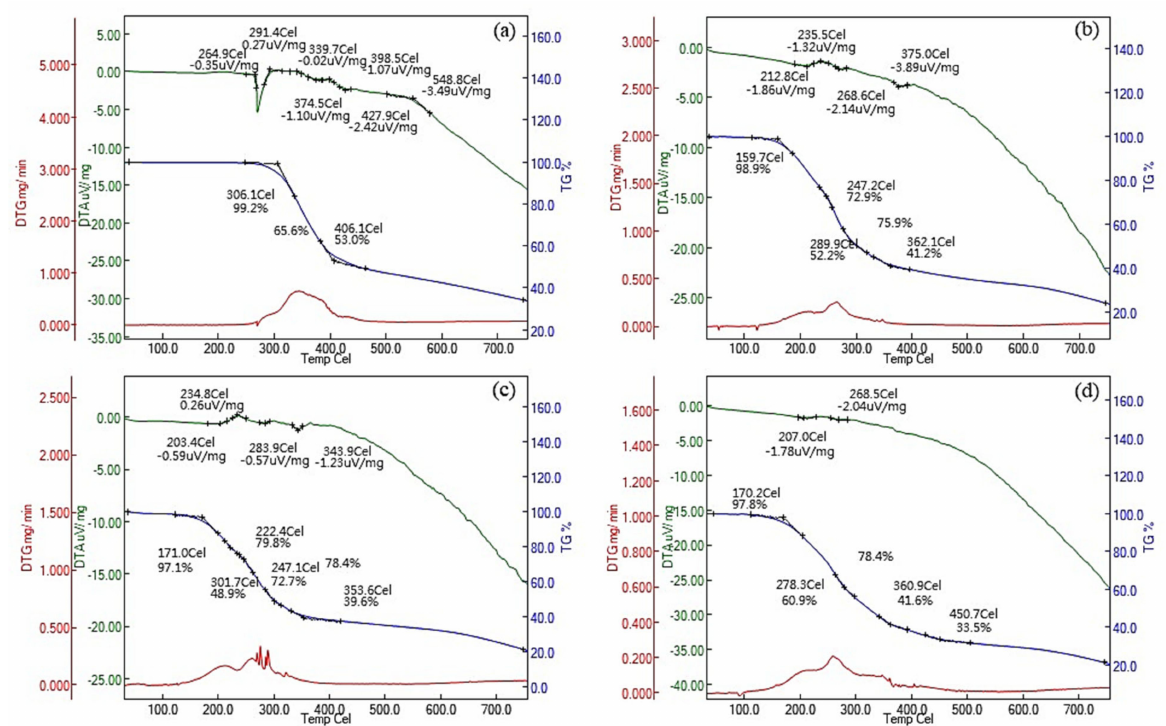
Figure 4. Thermograms of ( a ) pristine resveratrol (RE) and the products of the esterification of RE with ( b ) acetic, ( c ) propi- onic, and ( d ) butyric acids obtained under a nitrogen flow in the temperature range of 50–750 ◦